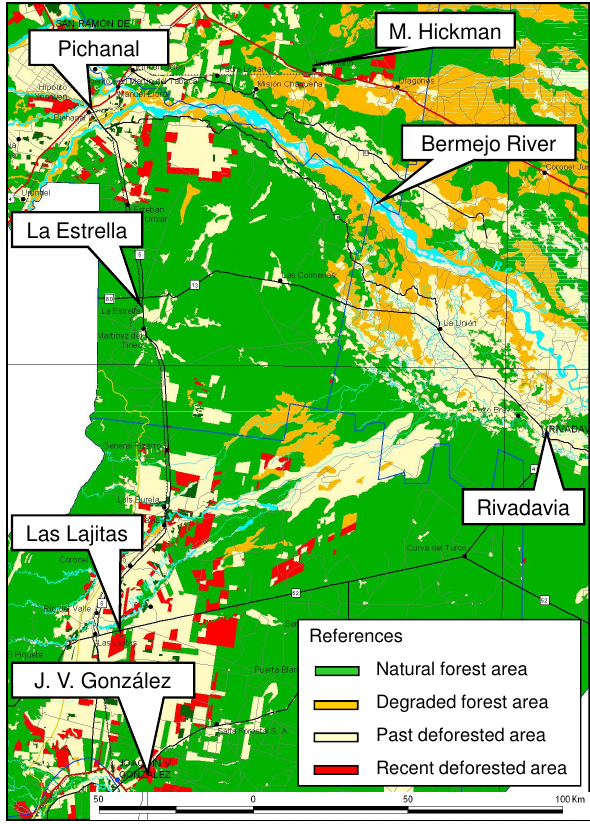
Fig. 2. Study area inside “Chaco Salte˜no” (Salta Province), with centers of sub zones. From Forest Map of Salta Province. State Secretary of Environmental and Sustainable Development, Argen- tine Republic, 2002; included in